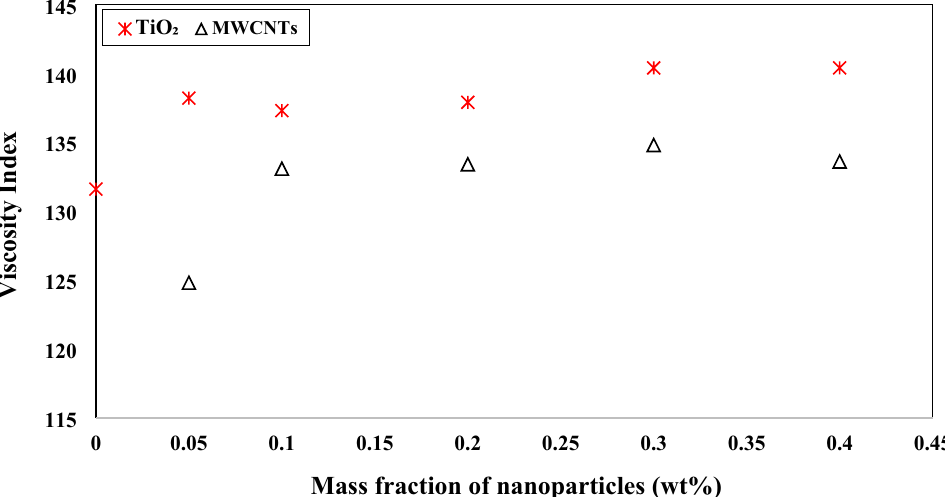
Figure 12. Comparison of viscosity index of TiO 2 /turbine meter oil and MWCNTs/turbine meter oil nanofluids.